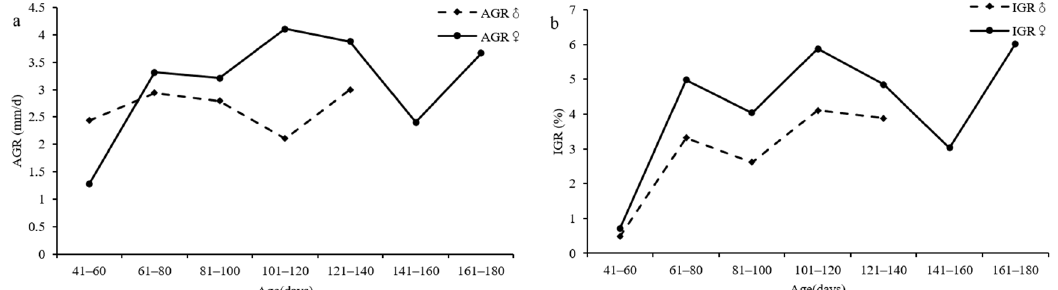
Figure 8. Relationships between the ML growth rate and age of B. magister shevtsovi samples: ( a ) AGR; ( b ) IGR.